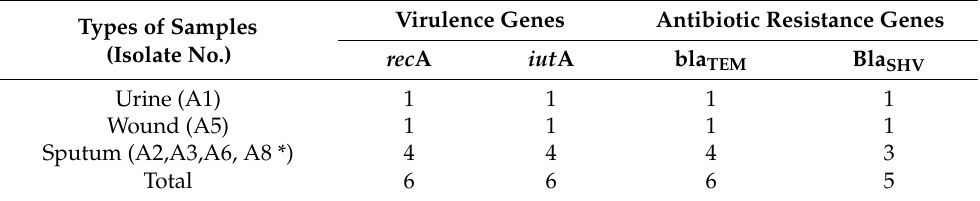
Table 2. Virulence and antibiotic resistant genes for the Acinetobacter baumannii isolates. Virulence Genes Antibiotic Resistance Genes Types of Samples (Isolate No.) rec A iut A